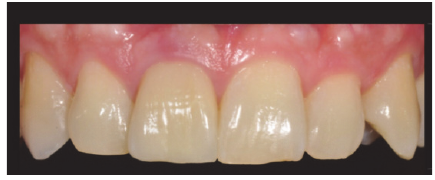
Figure 4: Crown just cemented. PES/WES final score: 20/20.